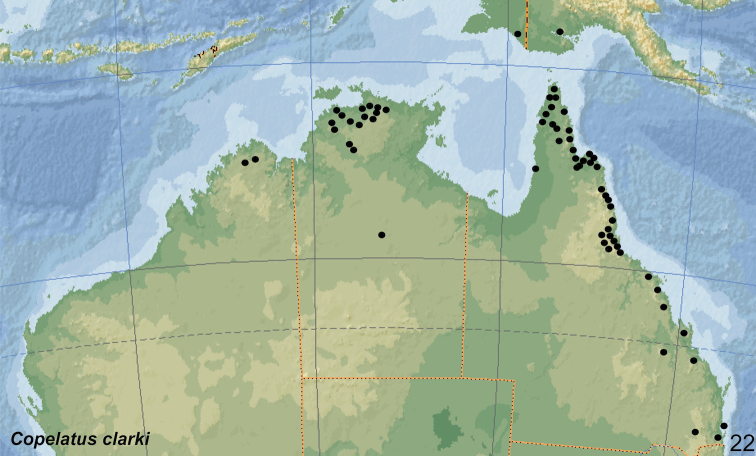
Distribution of Copelatus
clarki.